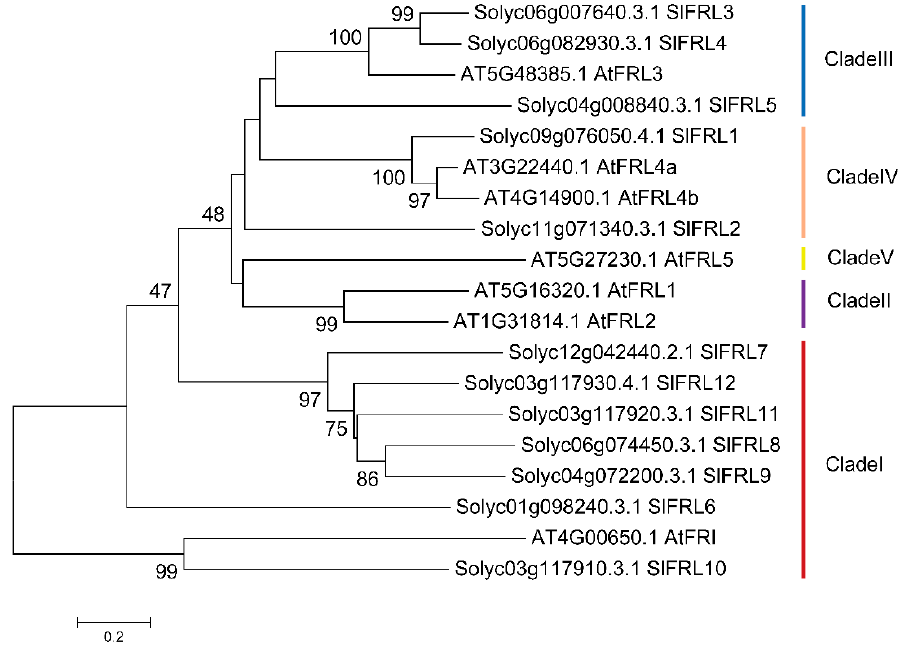
Figure 1. Cluster analysis of Frigida homologues in S. lycopersicum and A.